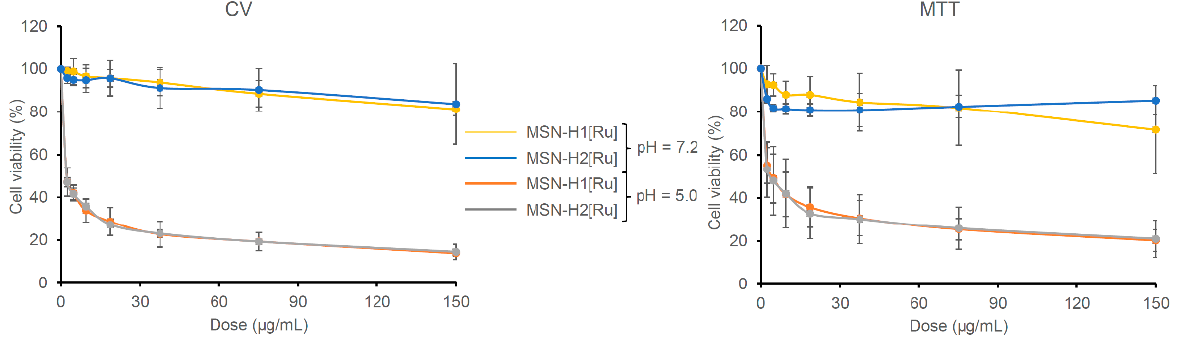
Figure 5. Viability of the B16F1 cells determined with CV and MTT assays treated (48 h) with different concentrations of investigated MSN on pH 5.0 and 7.2.